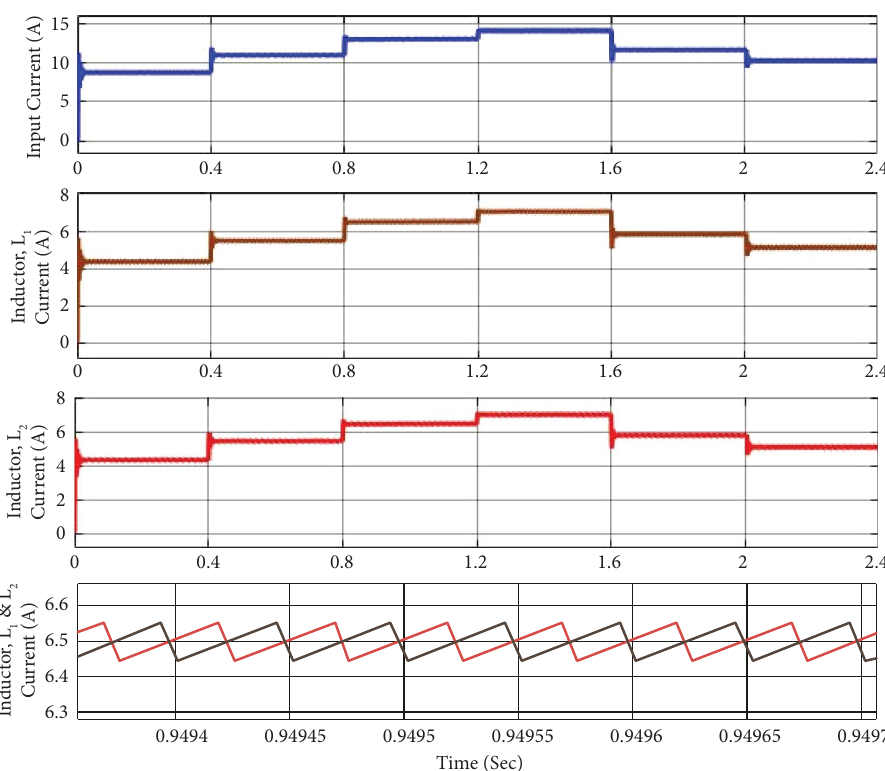
Figure 17: Current profle at input, inductor L